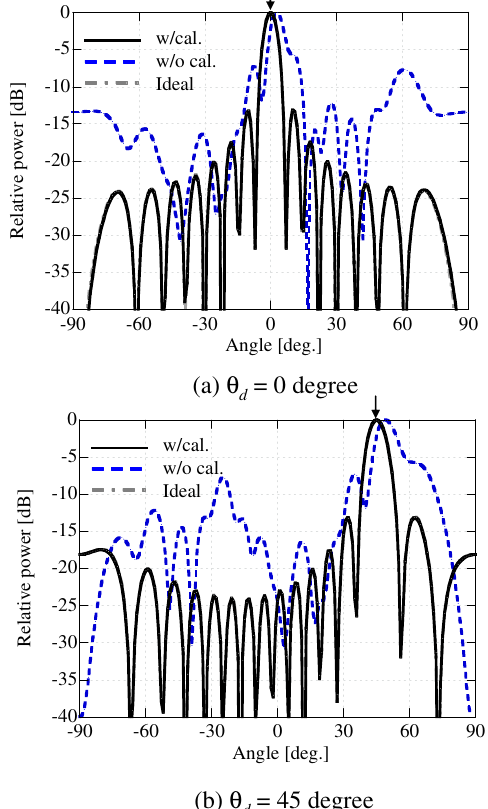
Figure 10. Array patterns with and without calibration: ( a ) θ d = 0 ◦ , and ( b ) θ d = 45 ◦